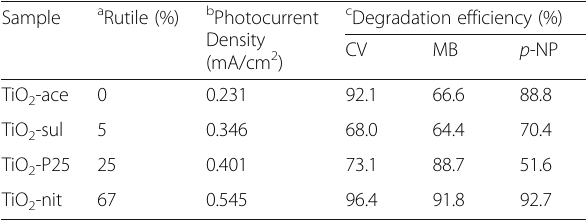
Table 4 Relation Between Rutile Percentage, Theoretical